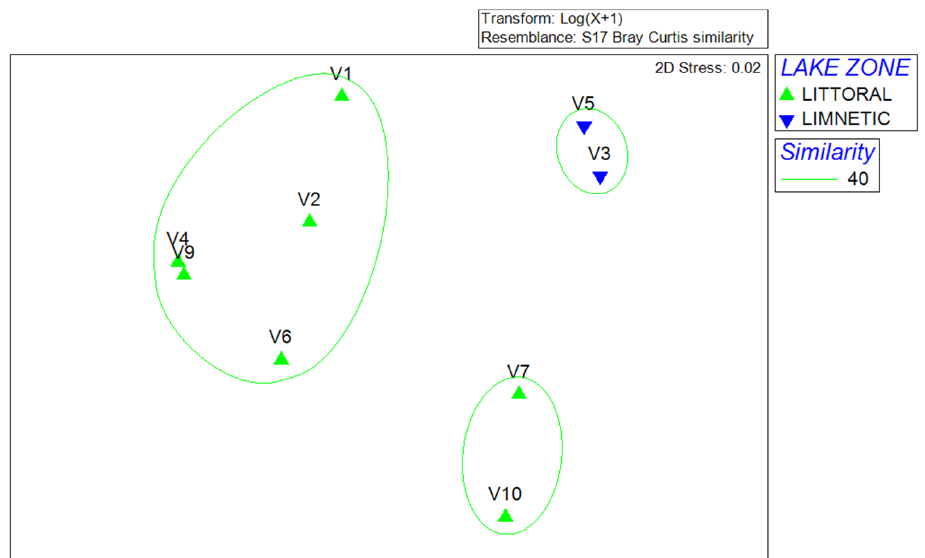
Figure 6. Non-metric multidimensional scaling (NMDS) ordination based on Bray–Curtis similarity distance in the taxonomic composition of phytoplankton community of composite samples on sampling stations (V1 to V10, excluding station V8) in Lake Visovac during August 2018 according to the morphological approach.